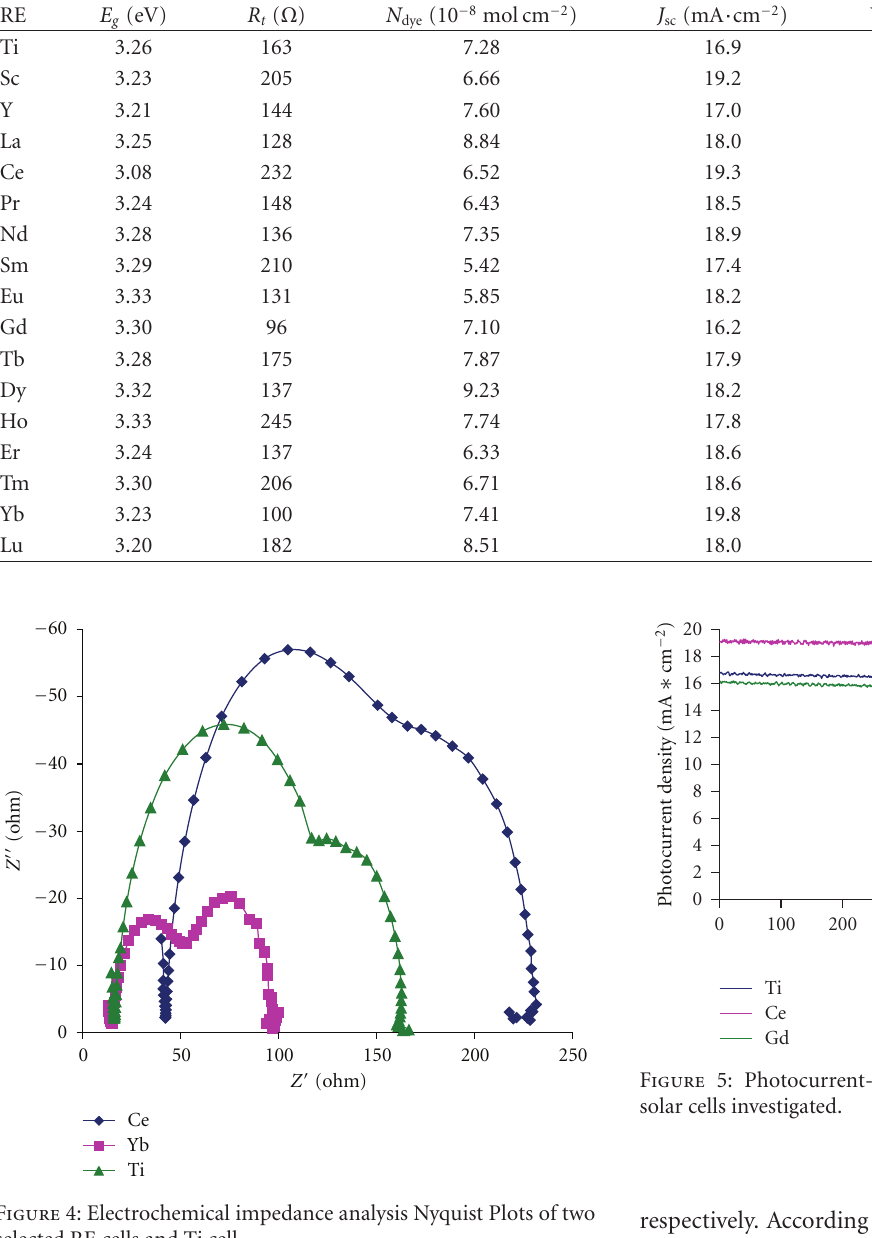
Table 1: The photoelectrochemical properties of the presented RE-modified photoelectrodes.